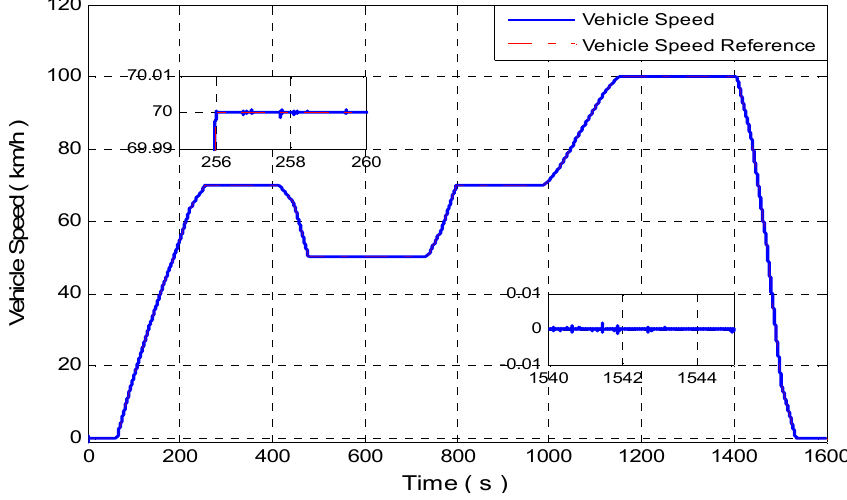
Figure 2. Vehicle speed and its reference, with zoom.